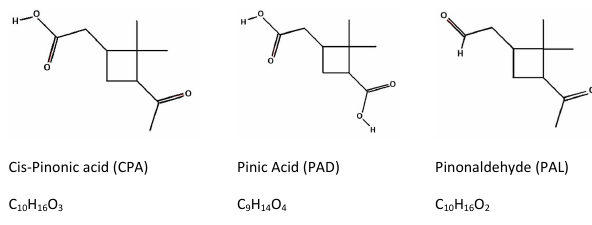
Fig. 1. Molecular structures of the three model HULIS compounds simulated in this study. The underlying objective in this novel study is to use molecular dynamics (MD) simulations to investigate surface tension for clusters of water and surfactants (CPA, PAD and PAL) of atmospheric relevance; to our knowledge the latter two compounds have not been experimentally determined previously. In the case of CPA a direct comparison is made with the experimental data by Shulman et al. (1996). Previous work by Nijmeijer et al. (1992), Zakharov et al. (1998), and Chakraborty and Zachariah (2008), have used MD to determine surface tension for water clusters. However, these studies are limited to water and fatty acids. We believe that the compounds in this study make out a good model for other surfactants present in the troposphere.